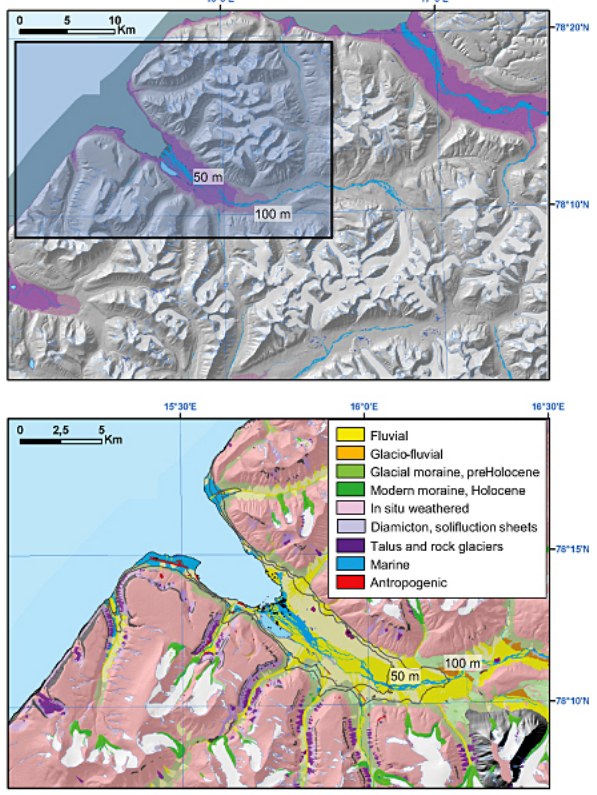
Fig. 8. Upper panel: hillshaded map of the Adventdalen area and surroundings. The two purple colours denote the 50m and 100m el- evation contour, respectively. Large areas within the valley bottoms draining to Isfjorden are laying within this zone. Lower panel: ge- omorphological map over the area around Longyearbyen (based on Tolgensbakk et al., 2000). The gray lines denote the contours from above. The area below 50m is mainly covered by marine sediments, beach deposits, fluvial infilling, slope sediment such as gelifluc- tion colluviums, alluvial fans and some singular bedrock outcrops, mainly in steep rock walls or coastal